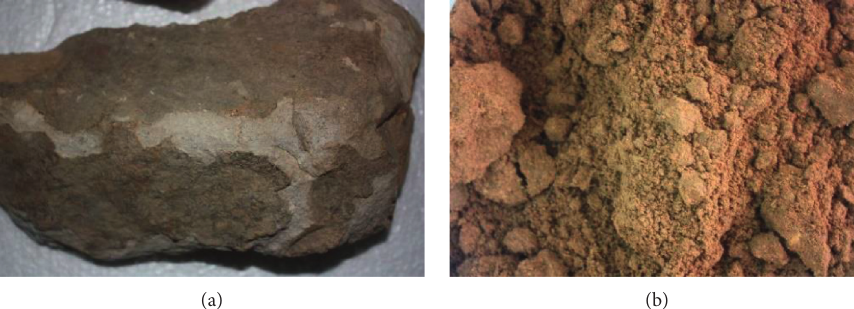
Figure 1: Natural state of kaolinite and weathered sandy soil sample. (a) Natural state of kaolinite. (b) Kaolinite weathered sandy soil.